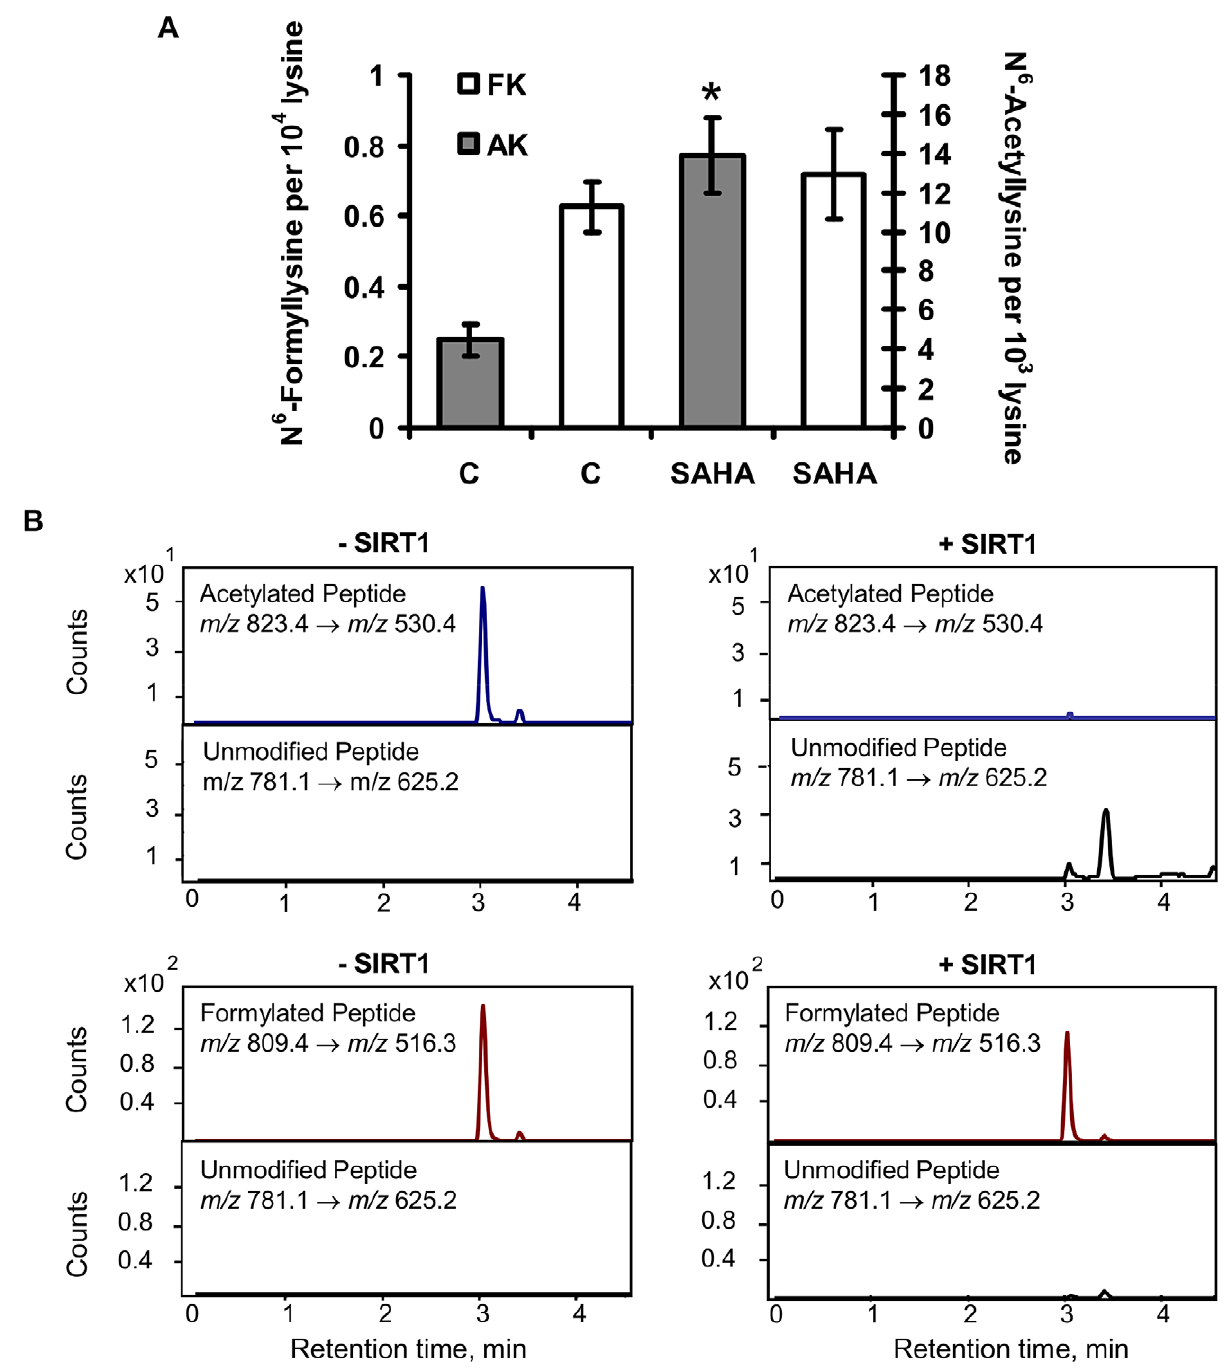
Figure 6. Effect of lysine deacetylases on N 6 -formyllysine. (A) TK6 cells were treated with the class I and class II histone deacetylase inhibitor, SAHA, as described in Materials and Methods . Data represent mean 6 SD for N=3, with asterisks denoting statistically significant differences by Student’s t-test (p , 0.05). (B) Treatment of peptide substrates containing N 6 -acetyllysine or N 6 -formyllysine with the class III histone deacetylase, SIRT1.